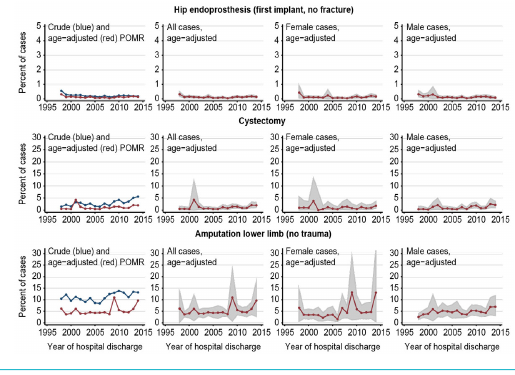
Figure 4: Increasing POMR trends in low- to high-risk IORs.Note: POMR = perioperative mortality rate. Note also that different per- centage scales are used for the first IOR and the second and third